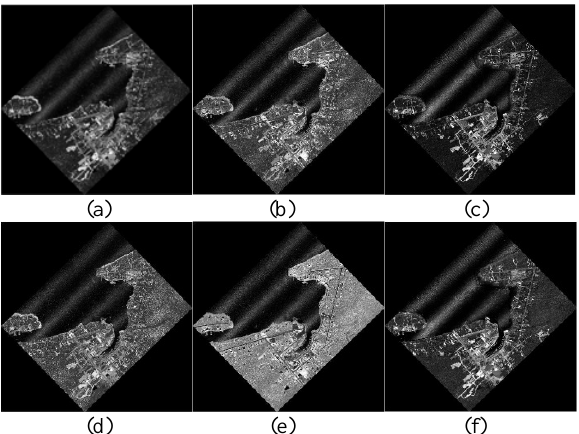
Figure 4. Multispectral ALS intensity models on the study area: (a) I SWIR+All+Avg ; (b) I NIR+All+Avg ; (c) I Green+All+Avg ; (d)I SWIR+First+Avg